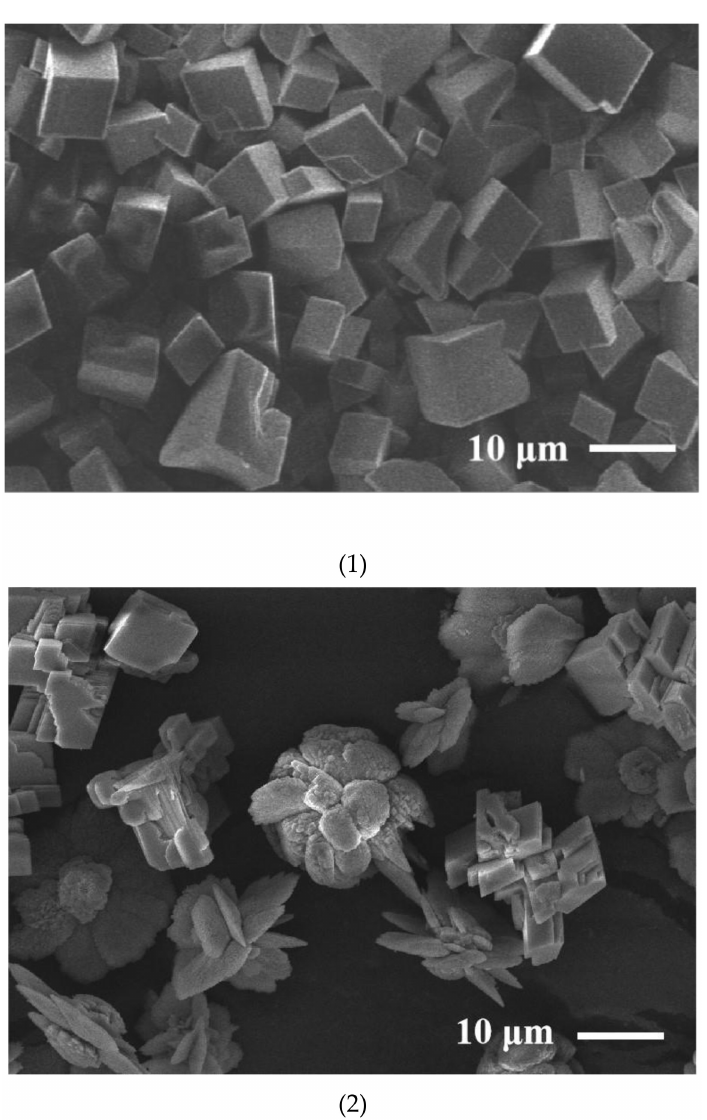
Figure 1. SEM images of CaCO 3 crystals generated in scale solution: ( 1 ) blank; ( 2 ) containing 8 mg / L